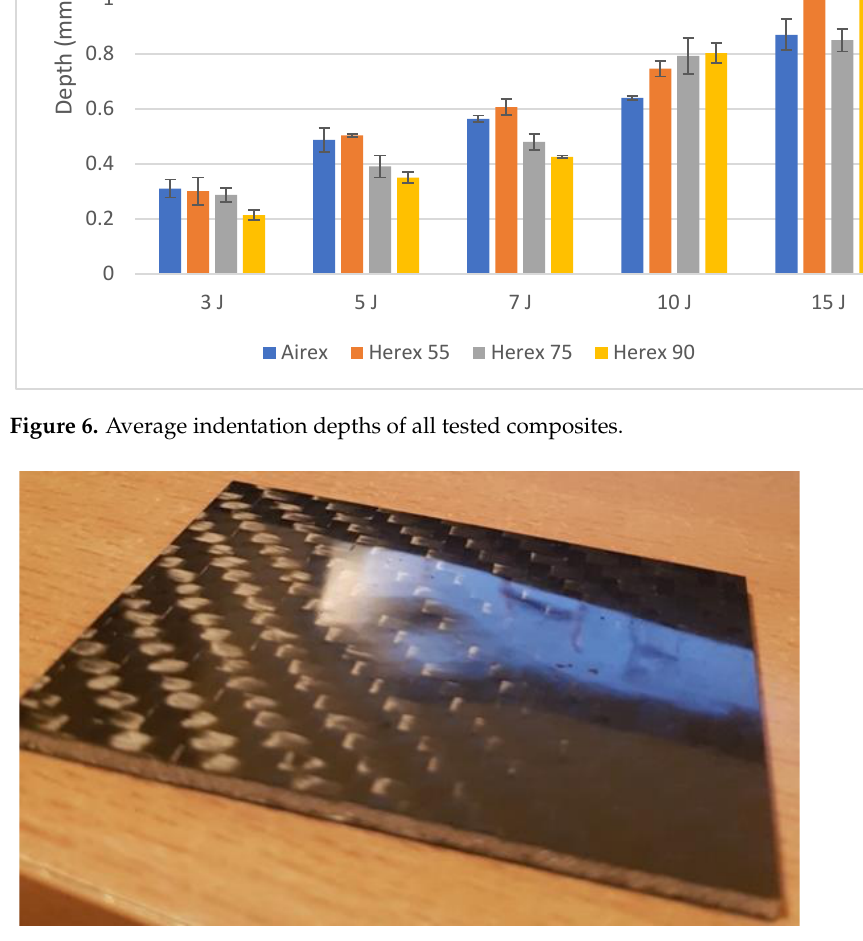
8 of 19 Figure 4. Sample on the table after a conducted test. Three samples of each type of a composite were tested, using the abovementioned parameters. As damage indicators, the depth of the indentation caused by the impactor loading the sample was measured (Figure 5). The depth was determined by means of a depth micrometer.